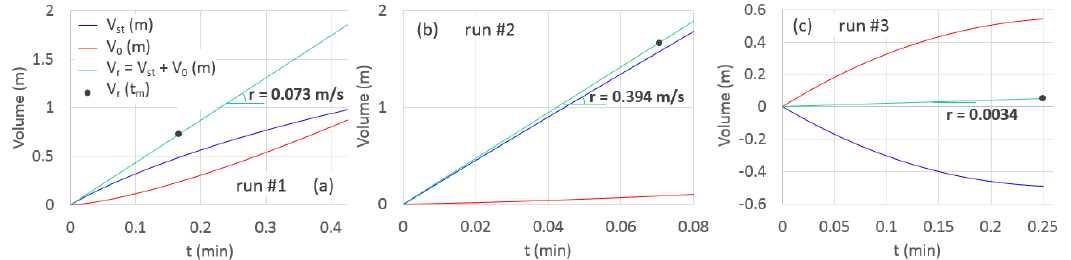
Figure 6. For ( a ) run #1, ( b ) run #2, and ( c ) run #3, volume stored in the tank, V st , volume flowing out Figure 6. For (a) run #1, (b) run #2, and (c) run #3, volume stored in the tank, V st , volume flowing out from the hole, V 0 , and runoff volume, V r . Black dots refer to V r at the time step, t m (Table 5). from the hole, V 0 , and runo ff volume, V r . Black dots refer to V r at the time step, t m (Table